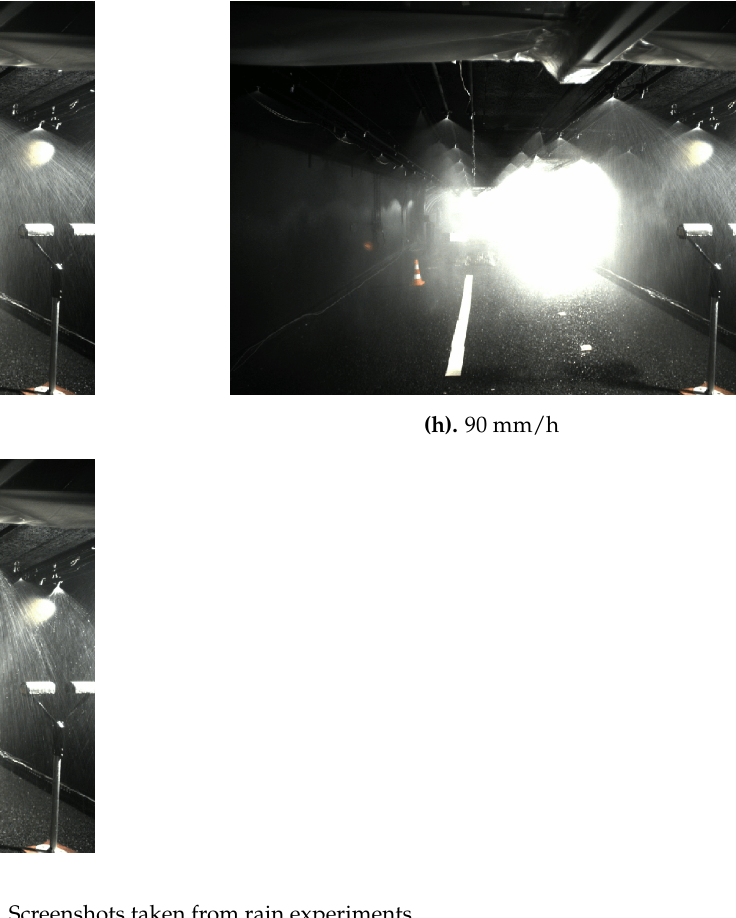
Figure 10. Screenshots taken from rain